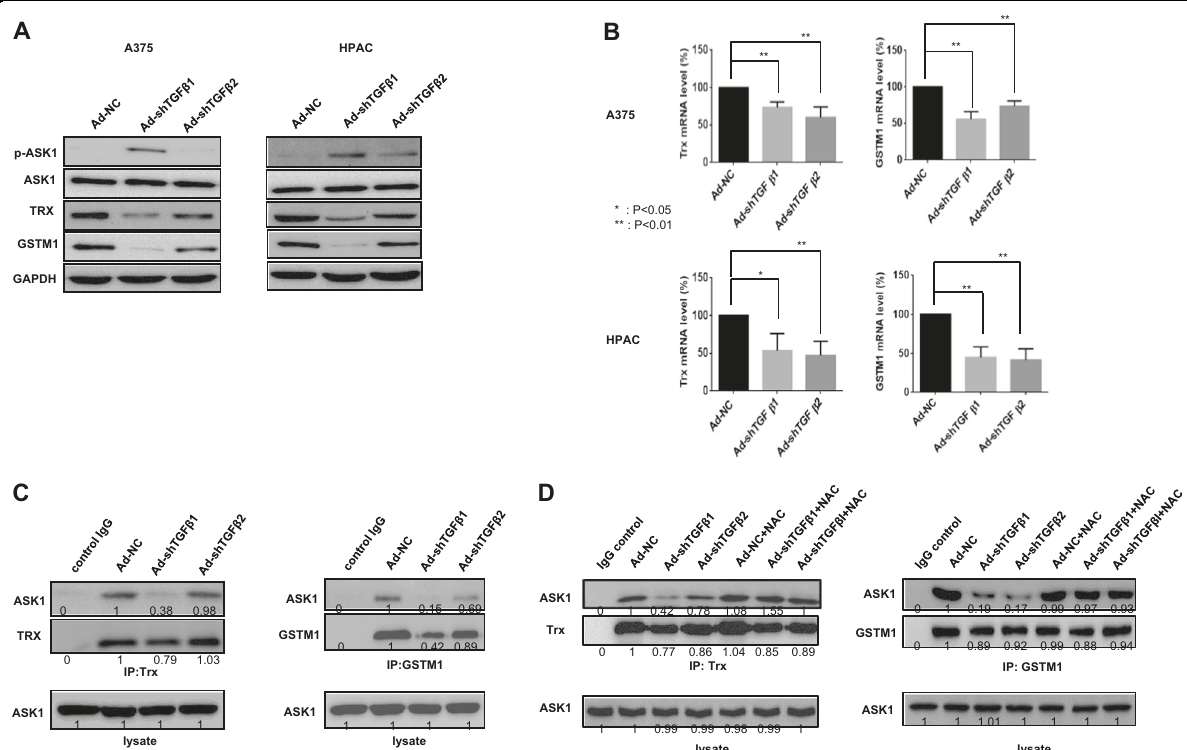
Fig. 4 Decreases in Trx and GSTM1 expression and the formation of complexes with ASK1 after TGF- β downregulation. a A375 and HPAC cells were infected with adenovirus expressing shTGF- β 1 or - β 2 at 100 MOI, respectively. After 48 h, the expression levels of p-ASK1, ASK1, Trx, GSTM1 and GAPDH were detected by western blot analysis. b A375 and HPAC cells were infected with adenovirus expressing shTGF- β 1 or - β 2 at 100 MOI, respectively. After 48 h, the expression levels of Trx and GSTM1 mRNA were assayed by quantitative real-time polymerase chain reaction (qRT-PCR). Error bars represent the standard error from three independent experiments. Asterisks indicate a signi fi cant difference compared to each given control (* p < 0.05; ** p < 0.01). c A375 cells were infected with adenovirus expressing shTGF- β 1 or - β 2 at 100 MOI. After 48 h, lysates were then subjected to immunoprecipitation with an anti ‐ Trx (Left) or anti ‐ GSTM1 (Right) antibody to identify changes in complex formation. The numbers indicate the relative band intensity to that of Ad-NC. d A375 cells were infected with adenovirus expressing shTGF- β 1 or - β 2 at 100 MOI. After 6 h, infected cells were treated with NAC (10 mM) for 42 h. Then lysates were subjected to immunoprecipitation with an anti ‐ Trx (Left) or anti ‐ GSTM1 (Right) antibody to identify changes in complex formation. The numbers indicate the relative band intensity to that of Ad-NC after measuring band intensity using a